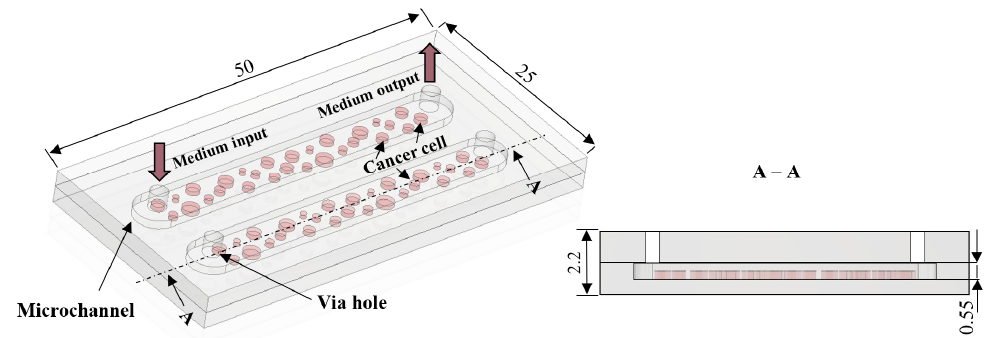
Figure 3. The concept of the LOC for culturing of human cancer cells: top view (on the left ), cross-section (on the right ). Dimensions are given in millimeters.